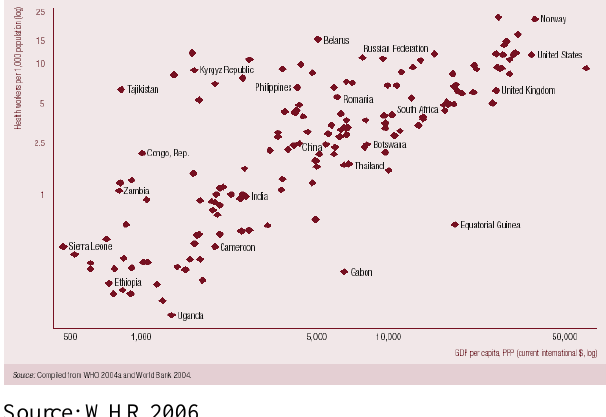
Figure 1 : Higher income—more health workers Distribution of health workers and burden of disease Ideally, countries with the highest burden of disease should have the greatest numbers of skilled health